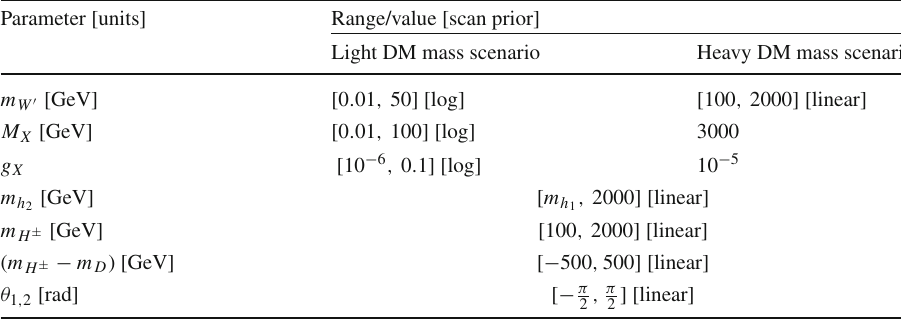
Table 1 The parameter space setup for the scan. For the light DM mass scenario, m W (cid:3) , m X and g X are scanned in log scale while the rest are in linear